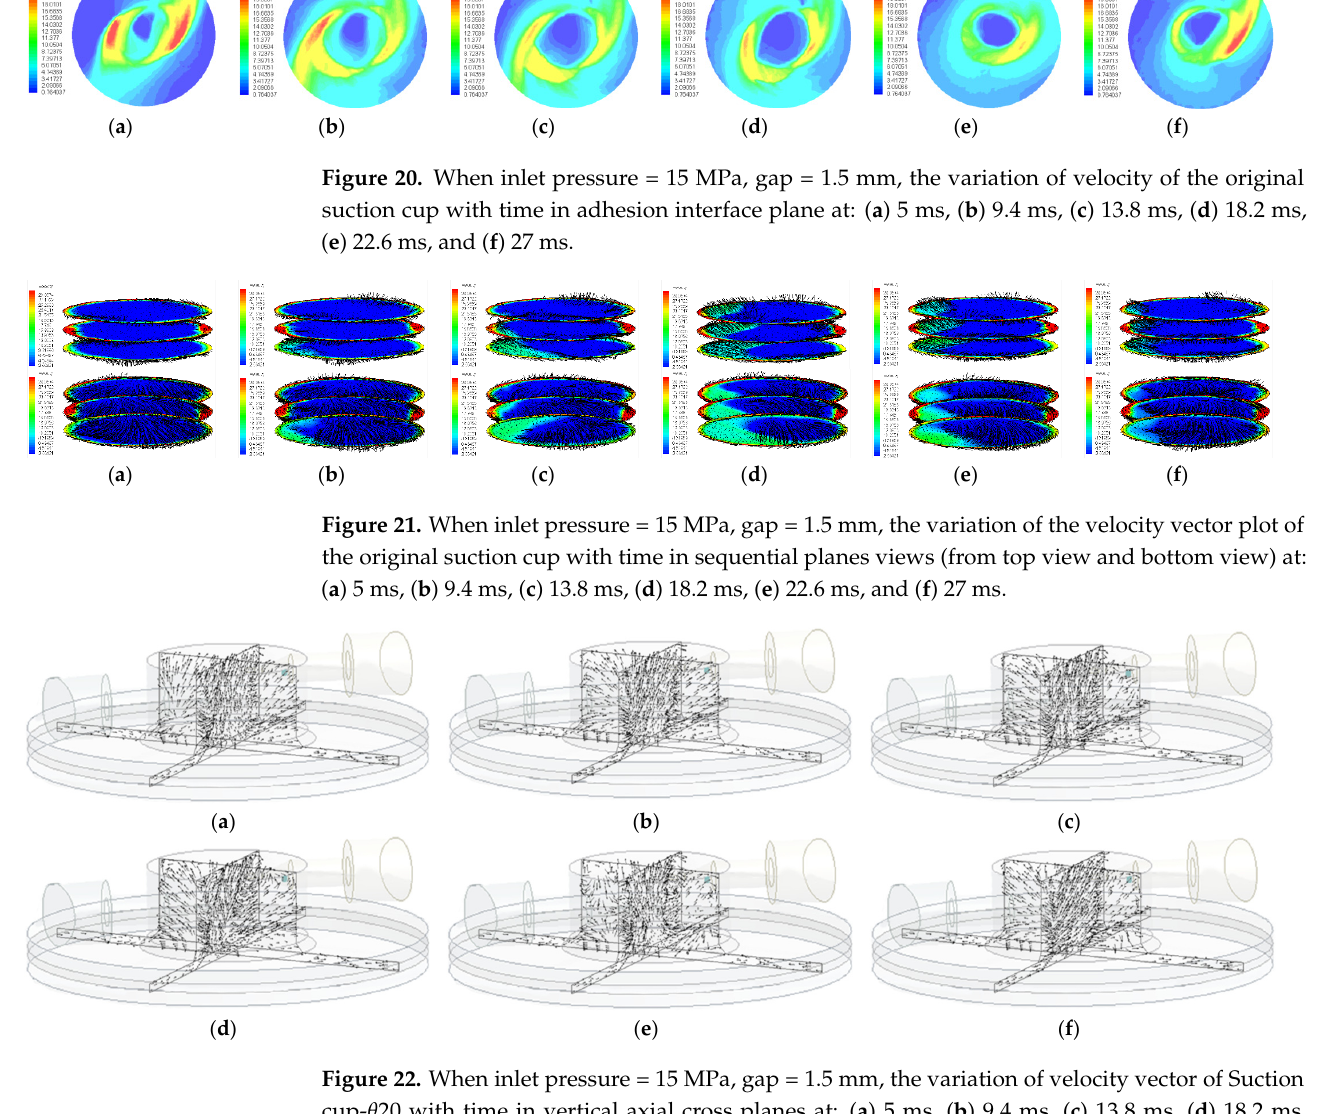
Figure 19. When inlet pressure = 15 MPa, gap = 1.5 mm, the variation of velocity of the original suction cup with time in vertical axial cross planes at: ( a ) 5 ms, ( b ) 9.4 ms, ( c ) 13.8 ms, ( d ) 18.2 ms, ( e ) 22.6 ms, and ( f ) 27 ms.